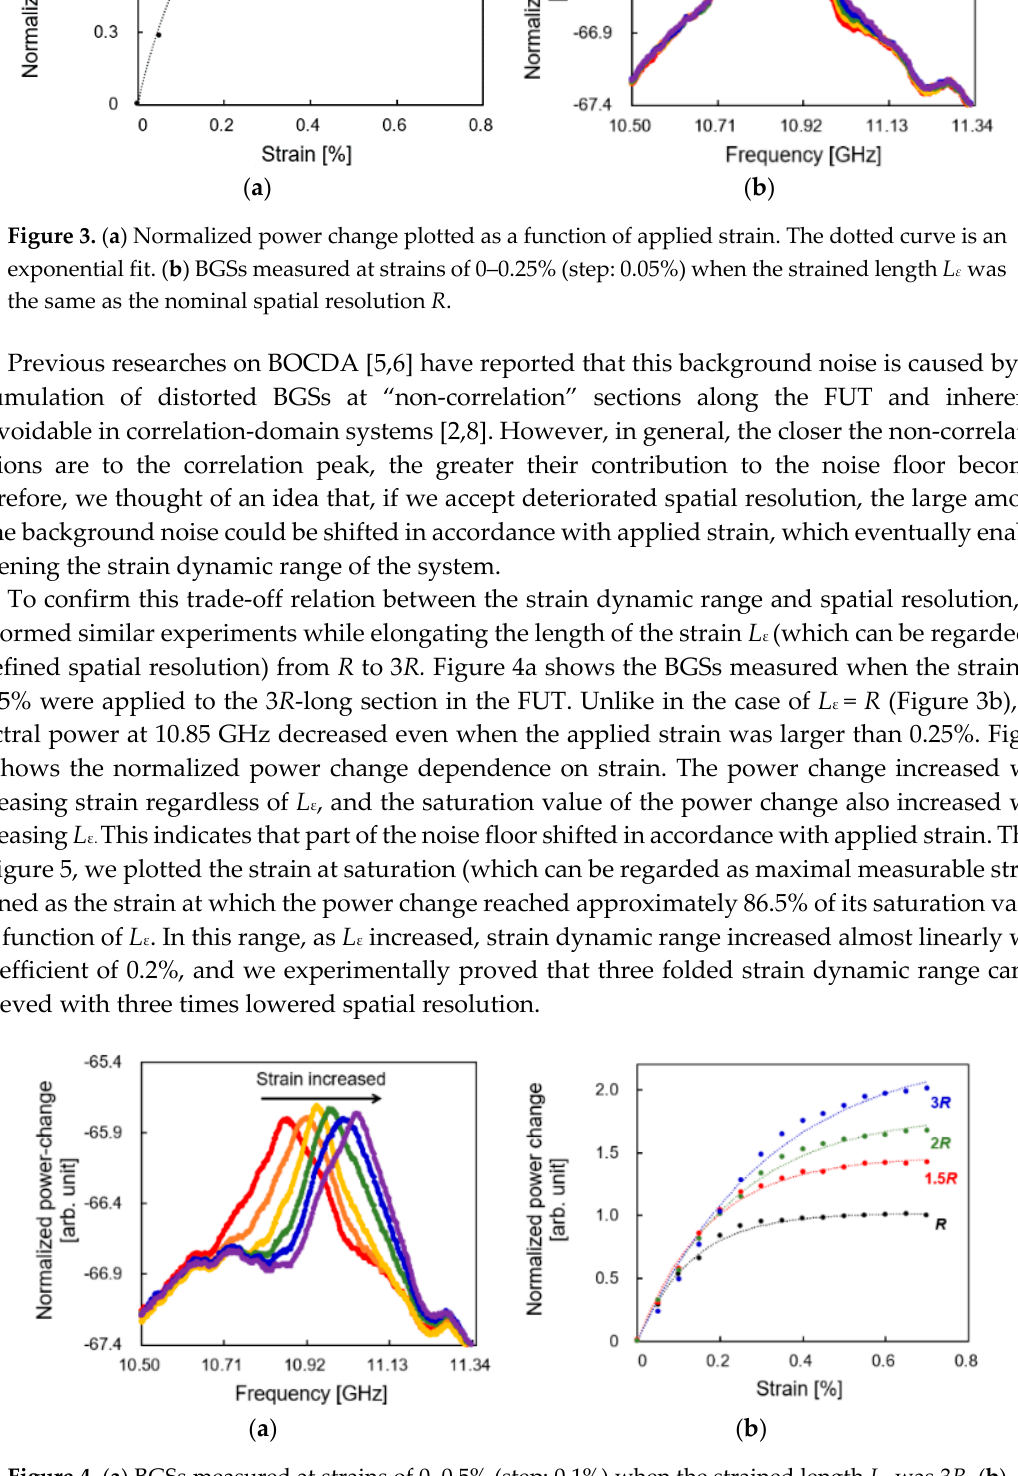
Figure 4. ( a ) BGSs measured at strains of 0–0.5% (step: 0.1%) when the strained length L ε was 3 R . ( b ) Normalized power changes plotted as functions of applied strain when the strained lengths L ε were R , 1.5 R , 2 R , and 3 R . The dotted curves are exponential